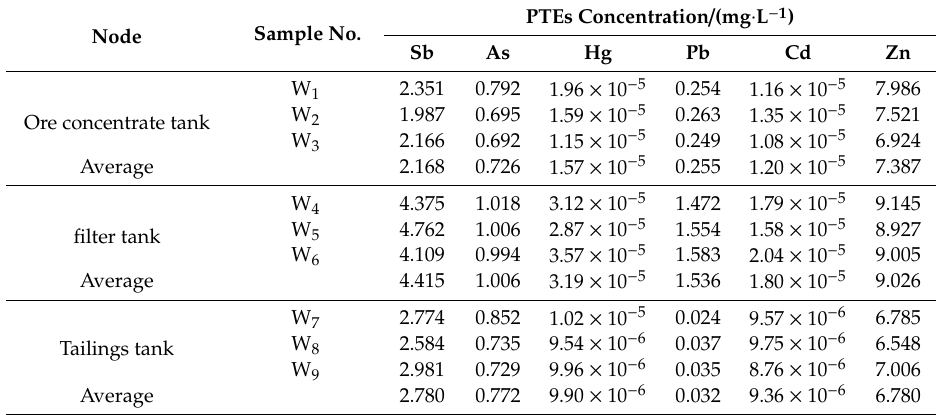
Table 1. The concentration of target potentially toxic elements (PTEs) in water samples collected from discharge points at the Xikuangshan (XKS) antimony mineral processing plant. Node Sample